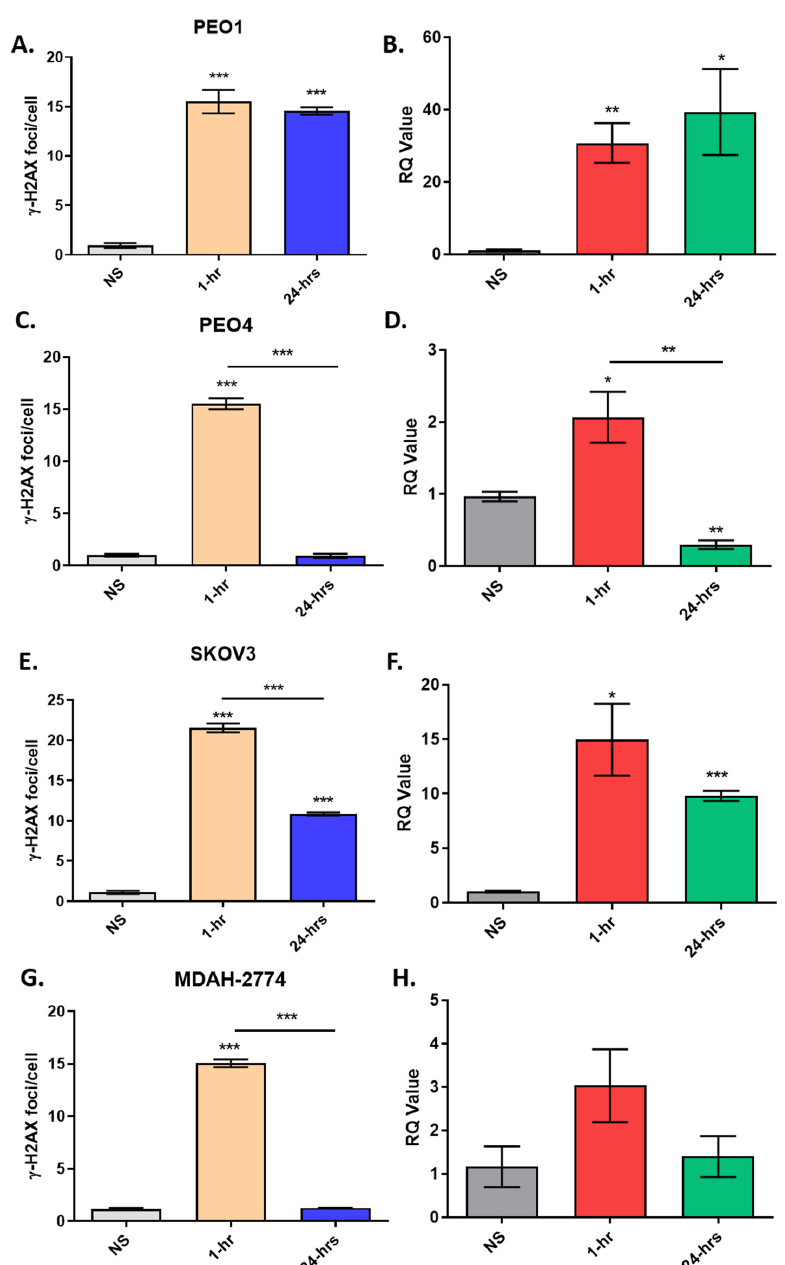
Figure 9. Treatment of cell lines with H 2 O 2 and measurement of γ -H2AX foci ( A , C , E , G ) and H2AX gene expression ( B , D , F , H ) in BRCA2 mutant PEO1 cell line ( A , B ), in comparison with BRCA2 silent mutant cell line PEO4 ( C , D ) and BRCA2 wild type SKOV3 ( E , F ) and MDAH-2774 ( G , H ). NS; No Supplement. Panel A . 1-hr: *** p < 0.0001, 24-hrs: *** p < 0.0001 (compared to NS). Panel B. 1-hr: ** p = 0.0056, 24-hrs: * p = 0.0322 (compared to NS). Panel C. 1-hr: *** p < 0.0001 (compared to NS). *** p < 0.0001 (1-hr compared to 24-hrs). Panel D. 1-hr: * p = 0.0375, 24-hrs: ** p = 0.0016 (compared to NS). ** p = 0.0078 (1-hr compared to 24-hrs). Panel E. 1-hr: *** p < 0.0001, 24-hrs: *** p < 0.0001 (compared to NS). *** p < 0.0001 (1-hr compared to 24-hrs). Panel F. 1-hr: * p = 0.0134, 24-hrs: *** p < 0.0001 (compared to NS). Panel G. 1-hr: *** p < 0.0001 (compared to NS). *** p < 0.0001 (1-hr compared to 24-hrs).